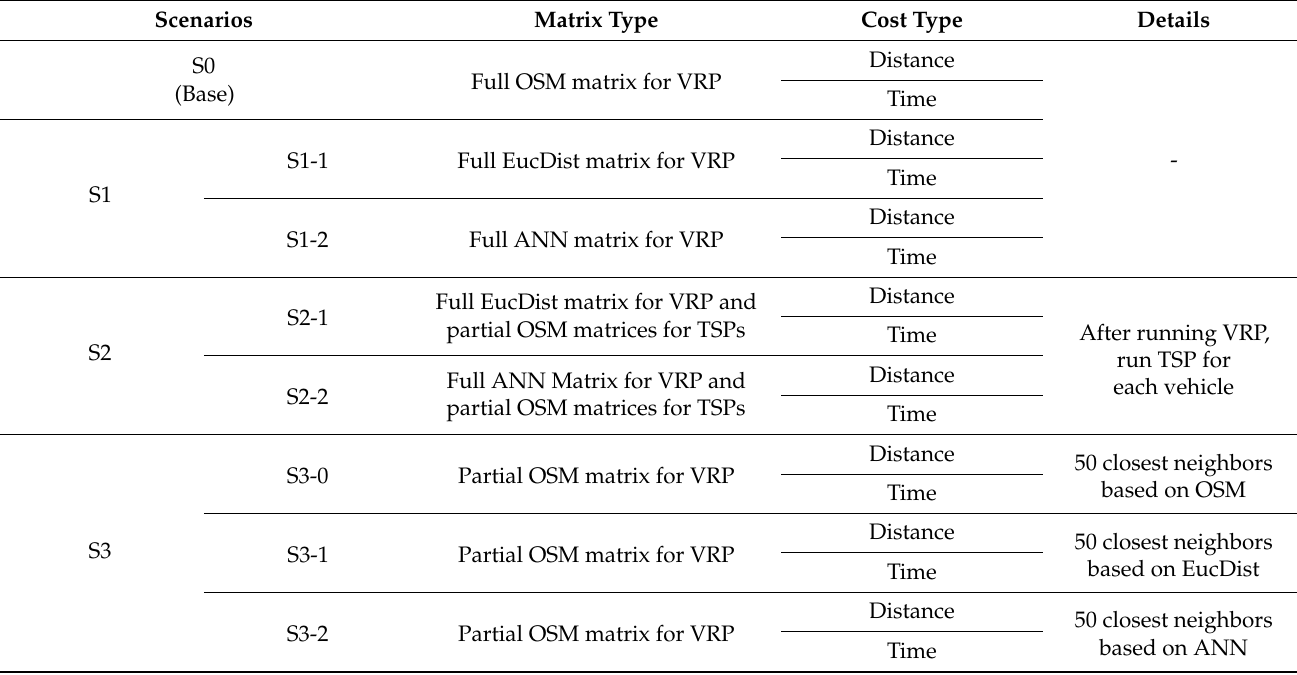
Table 2. Implementations scenarios of the ANN on